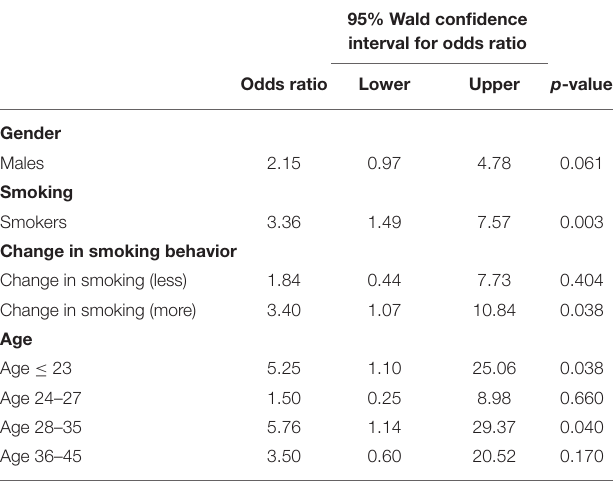
TABLE 4 | Logistic regression analysis of the odds of an increased frequency of excessive drinking amongst